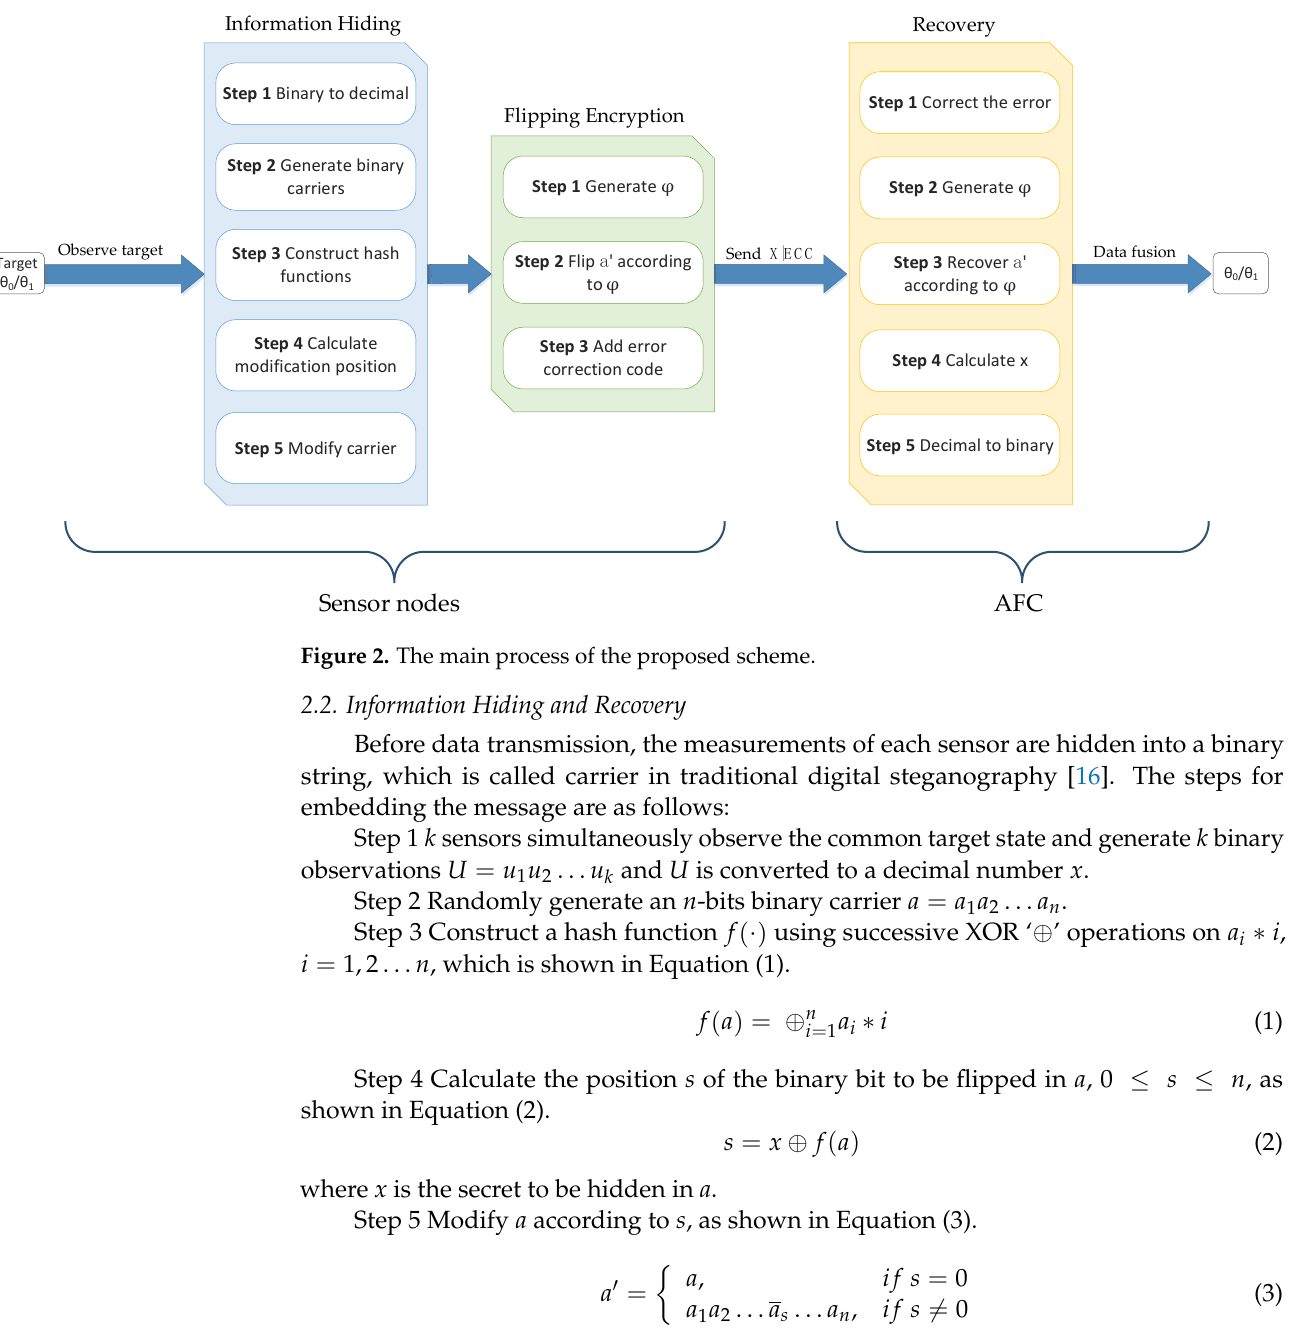
Figure 1. The framework of a wireless sensor network with an ally fusion center and an eavesdrop- ping fusion center.